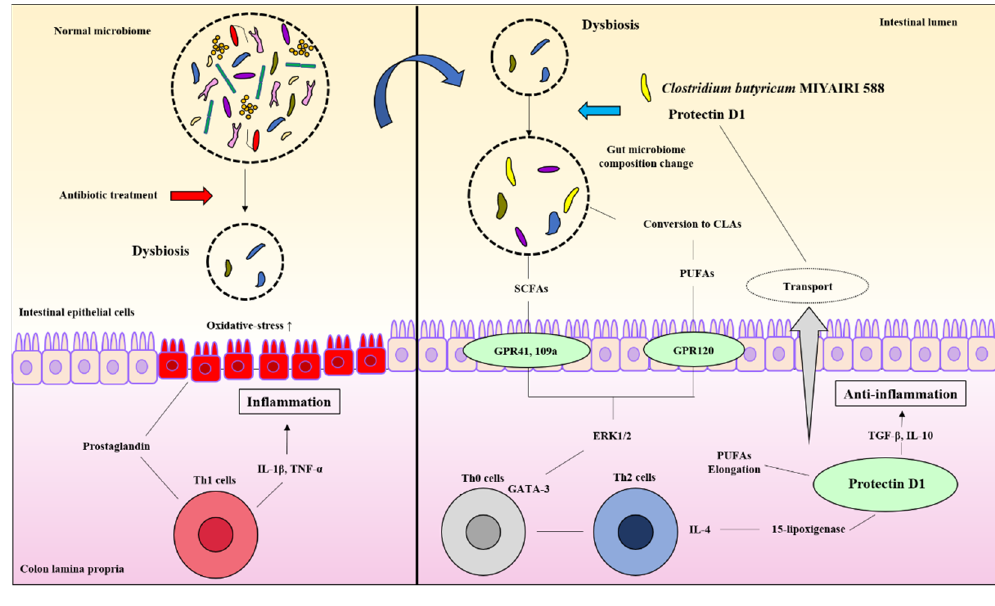
Figure 7. CBM 588 and host-producing lipid mediator modify lipid metabolism by changing the gut microbiome under antibiotic-induced dysbiosis.